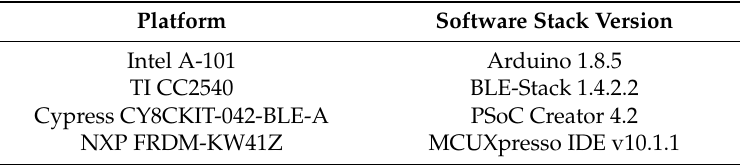
Table 1. Software stack version used to program the boards.